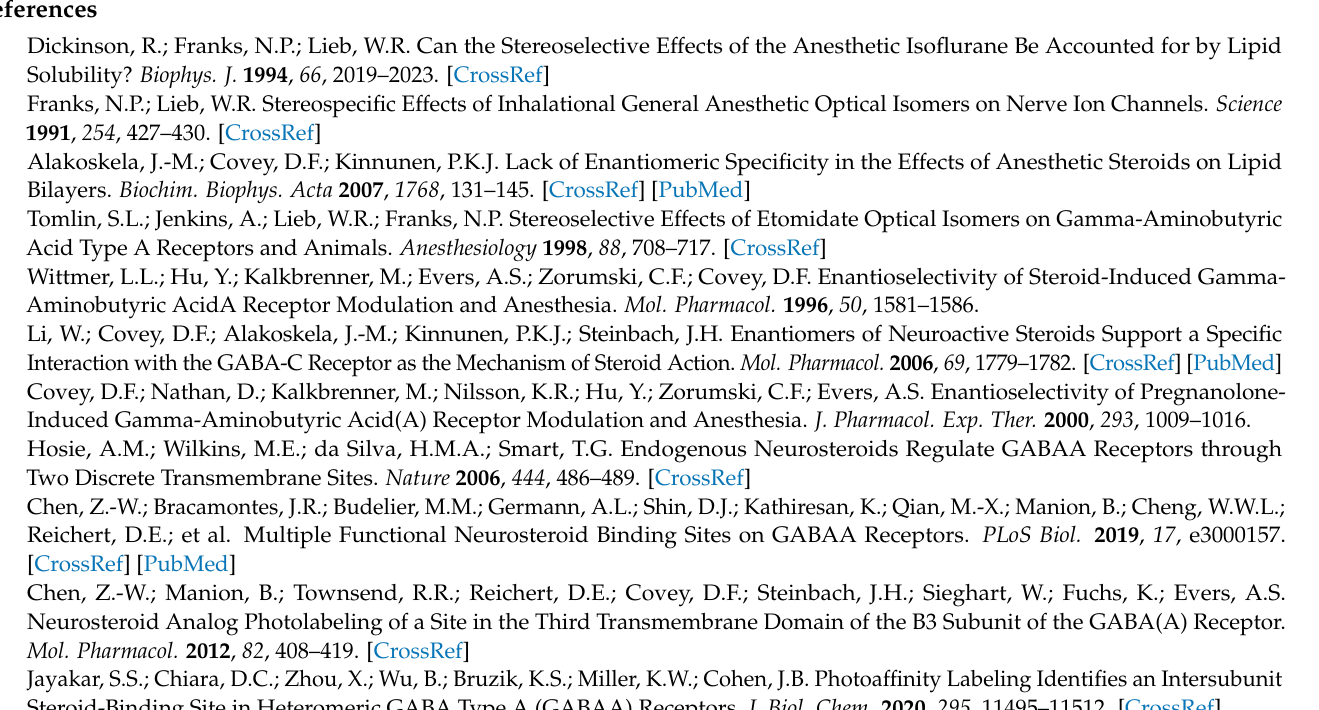
Figure S2: Mass spectrometric sequence coverage of α 1 and β 3 GABA A receptor